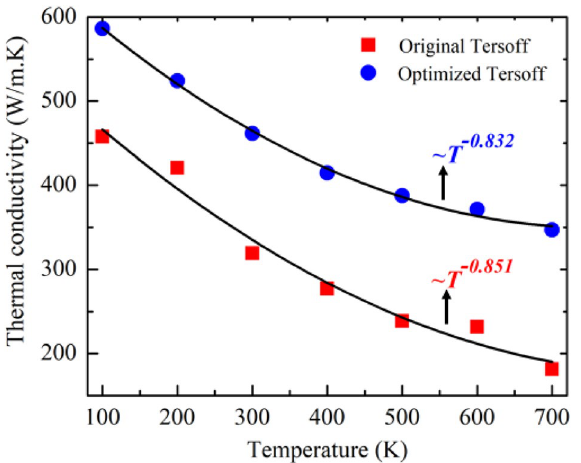
Figure 3. Temperature dependence of the thermal conductivity of the graphene/2D-SiC hetero-bilayer for two different potentials.